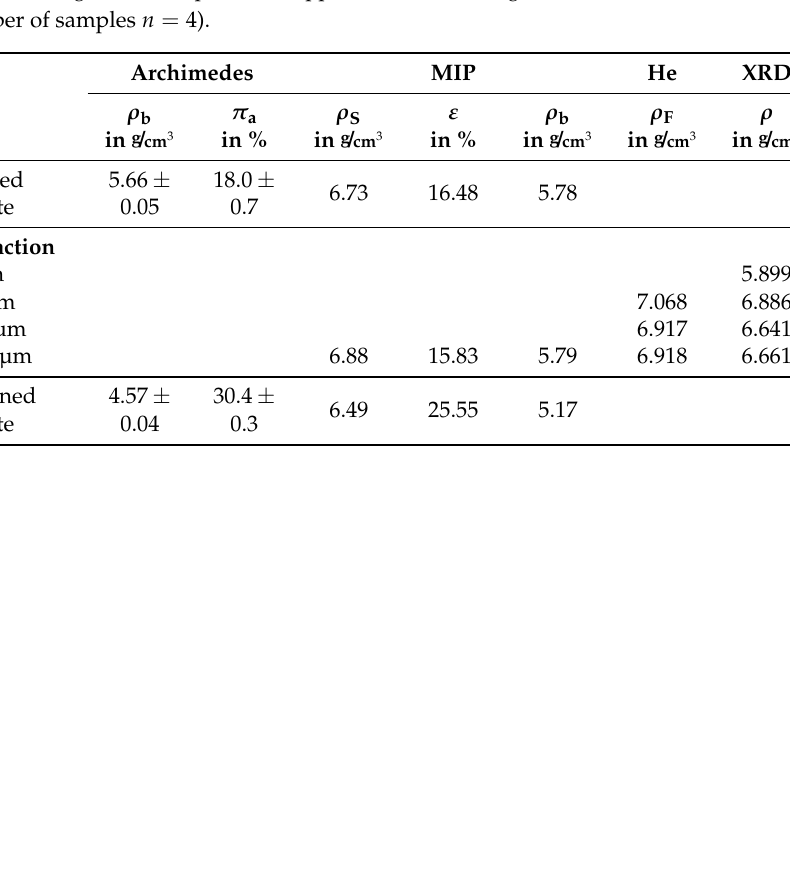
Table 4. Determined values of envelope density ρ b and open porosity π a according to DIN EN 993-1:2019-03, the skeleton density ρ S and porosity ε according to DIN ISO 15901-1:2019-03, and